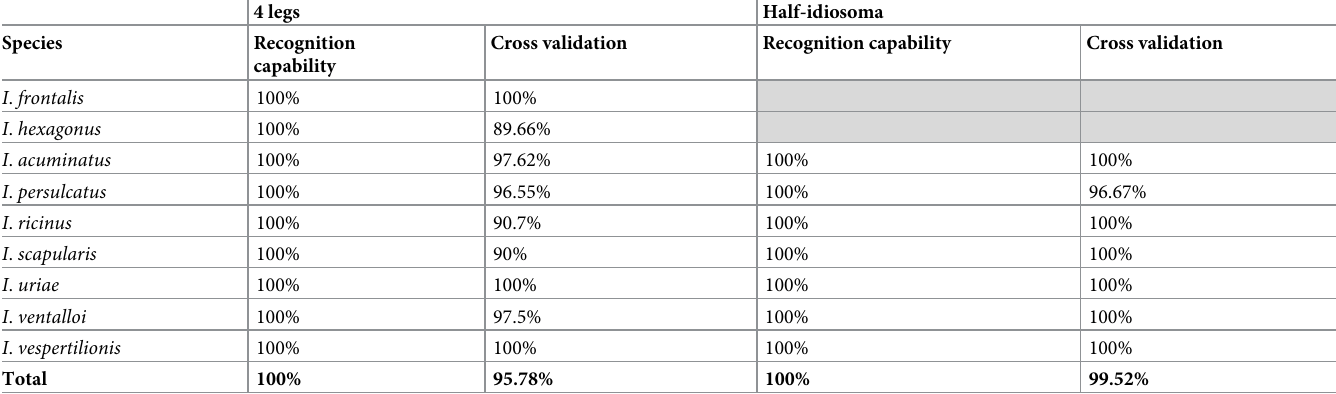
Table 3. Performance of the genetic algorithm based on the presence or absence of discriminatory peaks of the Ixodes species. The analysis was not performed for I . frontalis and I . hexagonus for the half–idiosoma because all specimens were